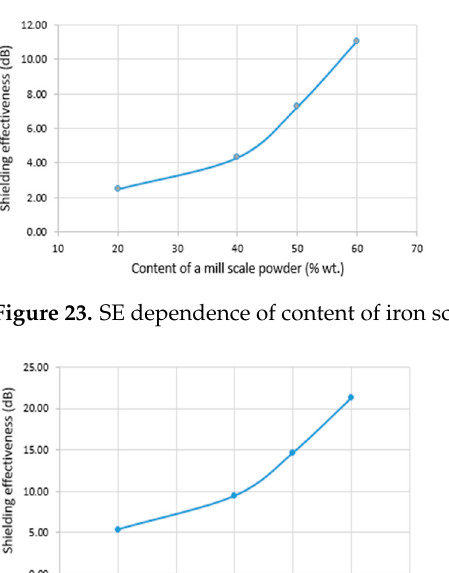
Figure 22. SE dependence of density. Iron scale powder. Frequency—10 GHz.